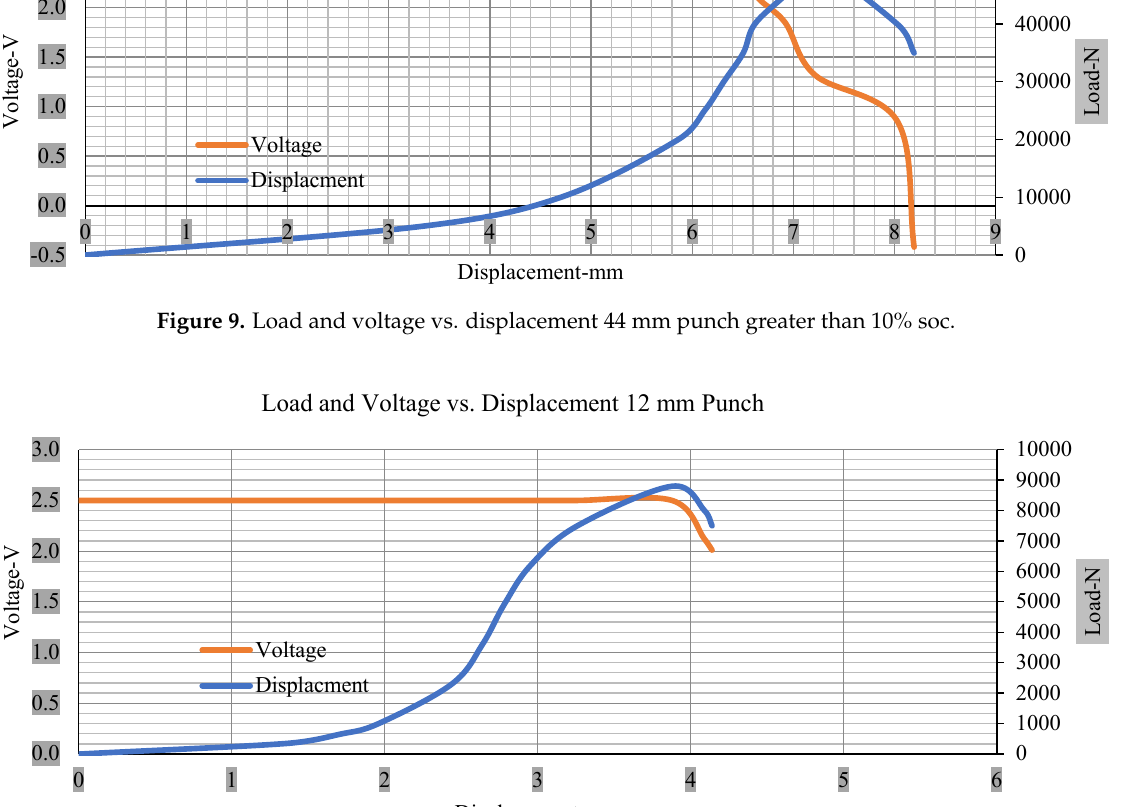
Figure 11. Load and voltage vs. displacement 25 mm punch less than 10% soc. With the exception of the small and medium punch studies, local deformation that can be securely tolerated from 6 mm (small cell) to 10 mm (medium cell) through the cell levels and even 12mm punch also did not produce much deformation, as shown in Figures 6–13.